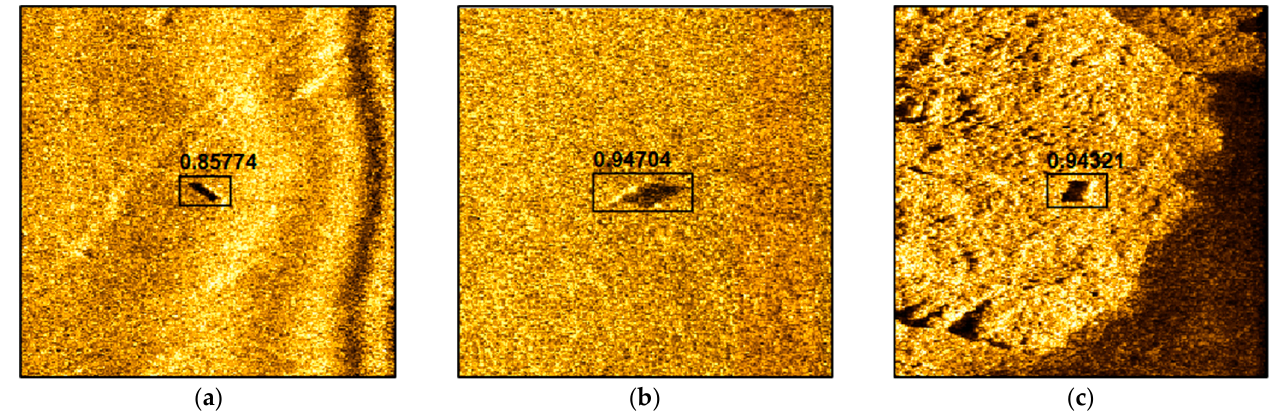
Figure 12. Examples of the detection results of the mock-up object with ( a ) mud, ( b ) sand, and ( c ) rock background through the YOLO network by applying the DarkNet-19 network and ADAM optimizer.